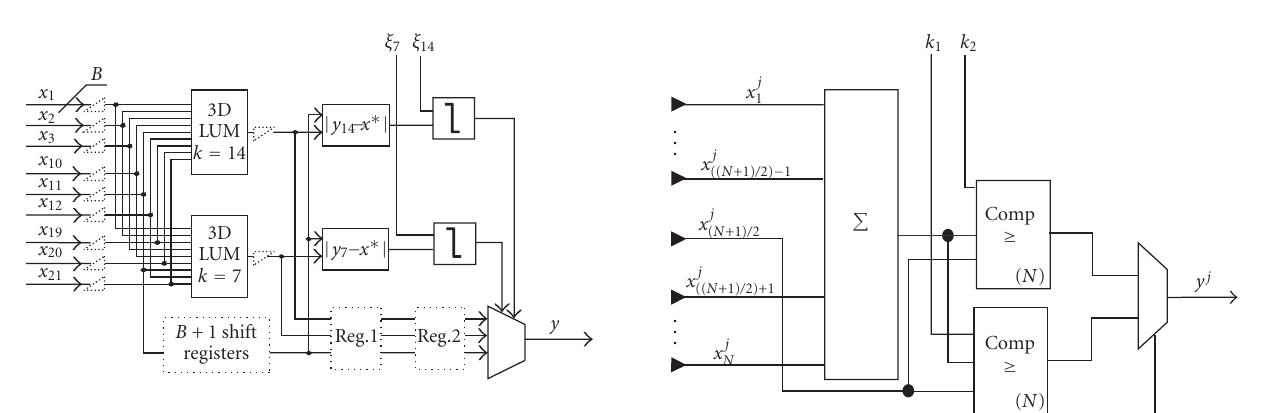
Figure 8: Pipelined structure of the reduced NAVF scheme.